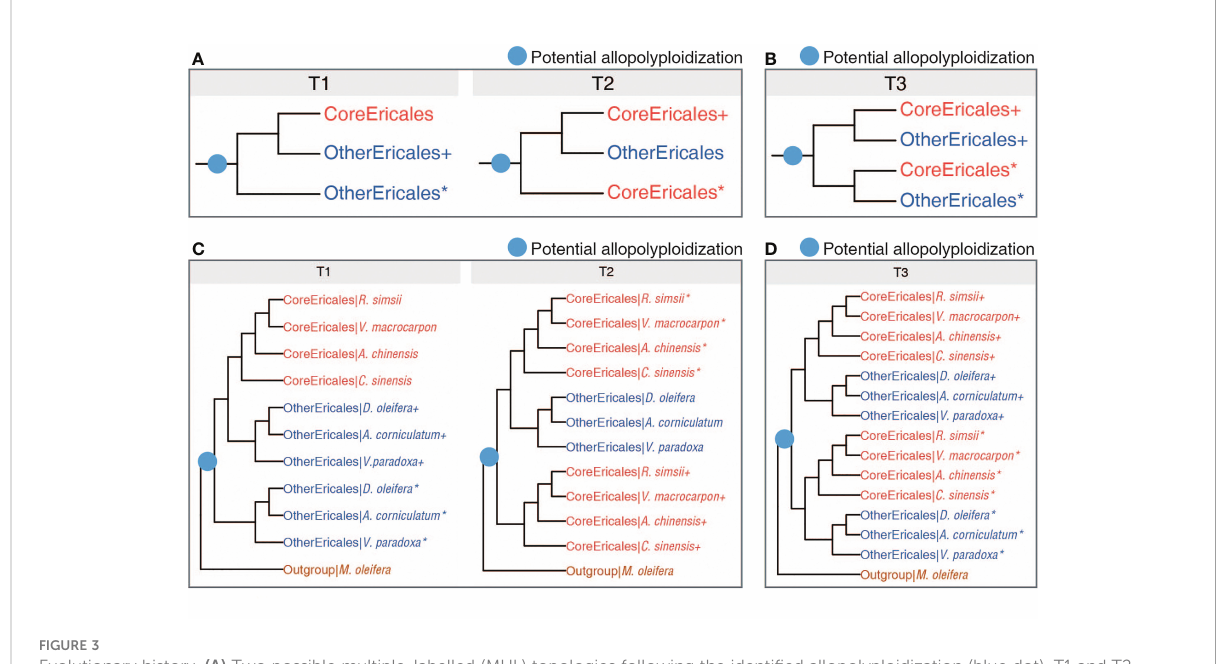
FIGURE 3 Evolutionary history. (A) Two possible multiple-labelled (MUL) topologies following the identi fi ed allopolyploidization (blue dot). T1 and T2 represent the scenarios with one copy of duplicated genes loss following the identi fi ed allopolyploidization. (B) . One possible MUL topology (T3) indicating the scenario where two duplicated gene copies were retained following the identi fi ed allopolyploidization. (C, D) The referenced multi-labelled species trees supporting T1, T2 and T3, respectively. “ * ” and “ + ” respectively denote two copies of a gene duplication generated from one WGD, or respectively represent two descendants of different parental lineages in a hybrid